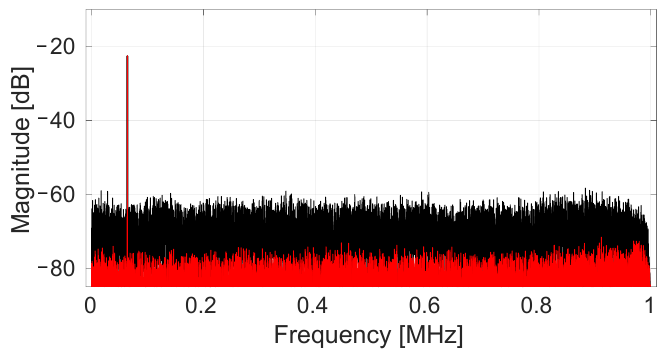
Figure 12. Measured output spectrum (32K FFT) for a magnetic input at 64kHz with amplitude 780 µ T. In black, no SS-ORL is active, and randomized offset is present modulated as pseudo noise. In red, the SS-ORLs are active, removing the randomized offsets. The 0dB reference level corresponds to a full scale signal output amplitude of